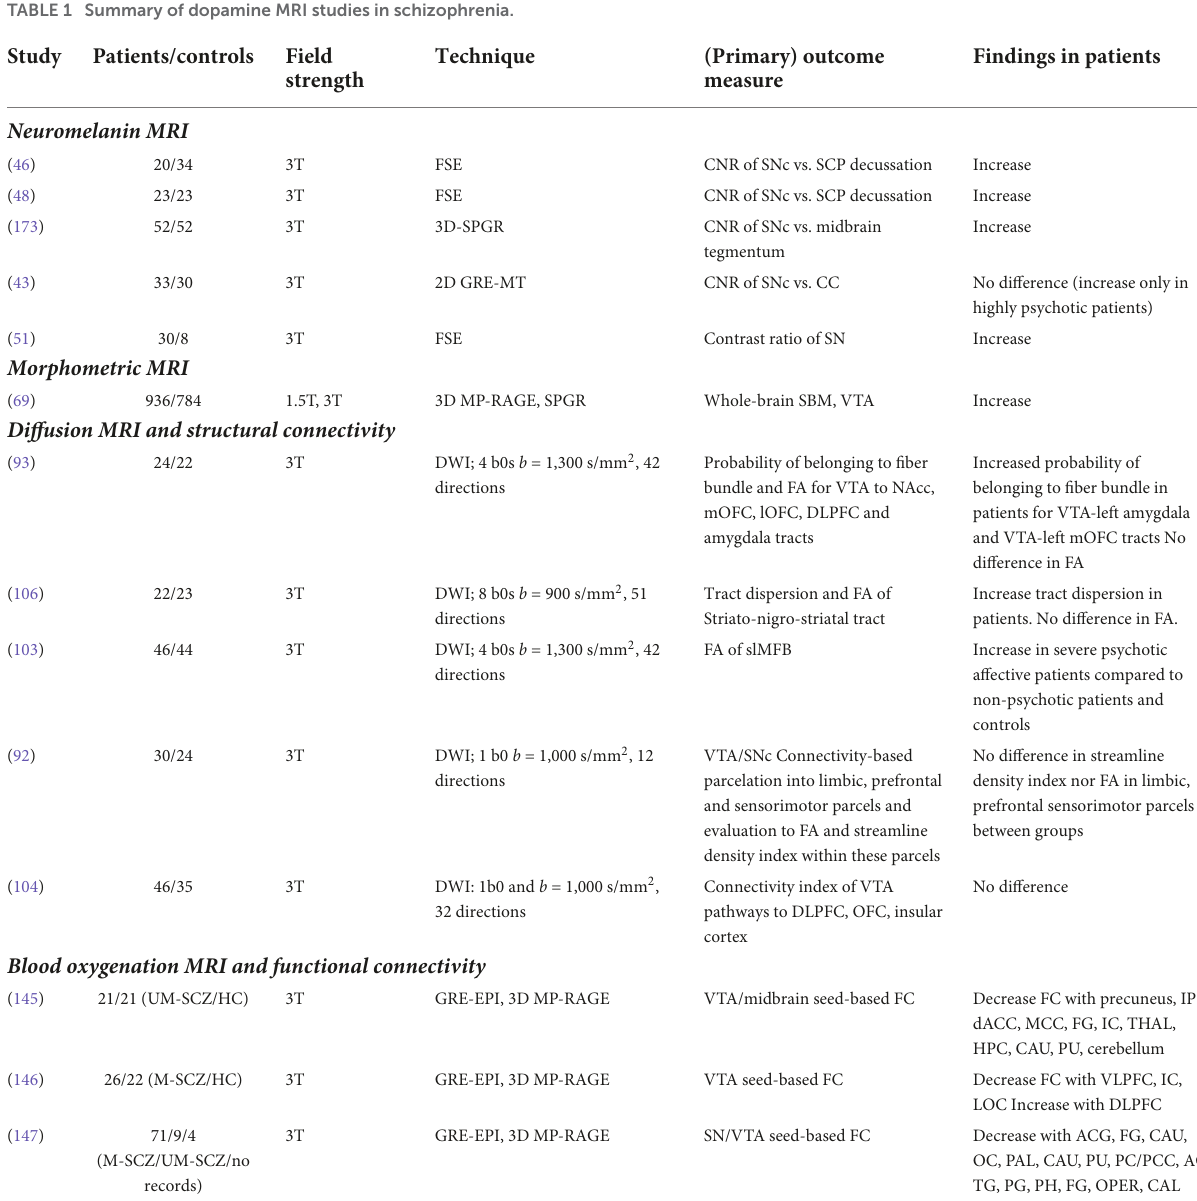
TABLE 1 Summary of dopamine MRI studies in